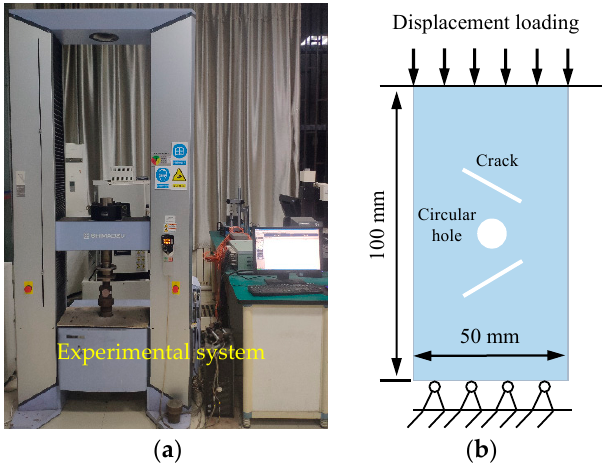
Figure 4. The testing machine and numerical calculation model. ( a ) The testing machine. ( b ) The numerical calculation model.